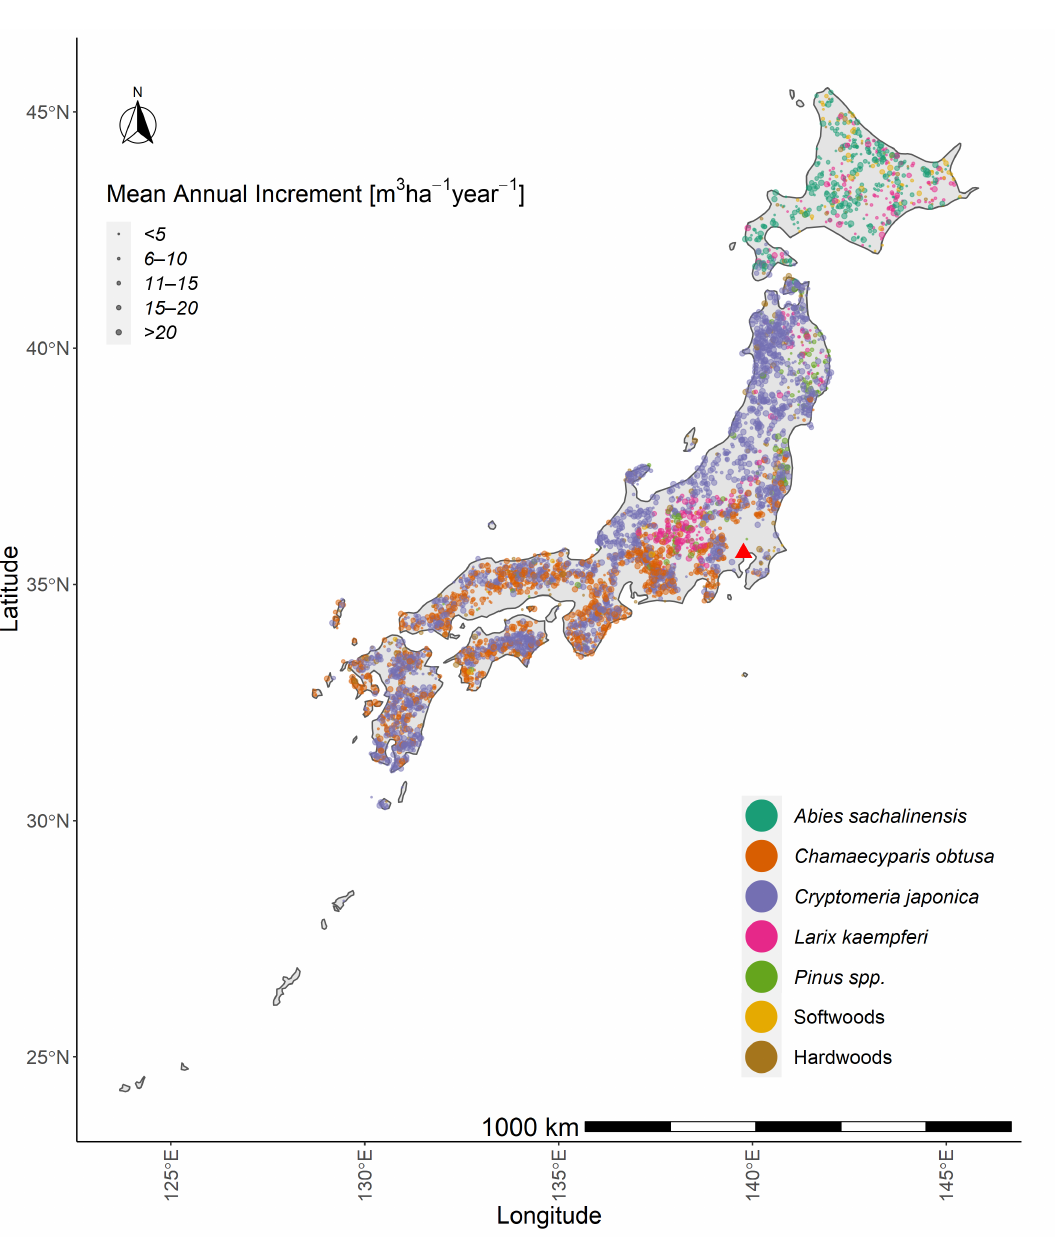
Figure 1. Dominant tree species in plantation forests in Japan. Jittering was applied to the points to reduce overlapping. Other hardwood species and softwood species were pooled into “hardwoods” and “softwoods”. The sizes of the circles show the approximate mean annual increment per plot. Data are from the Japanese National Forest Inventory (2013). The red triangle indicates